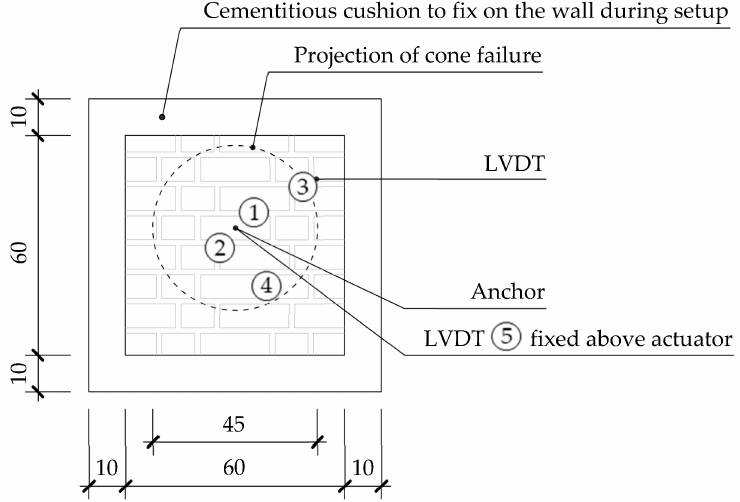
Figure 6. Setup for pull-out tests (dimensions in cm). Numbers in circles indicate LVDTs position. Adapted from [16].